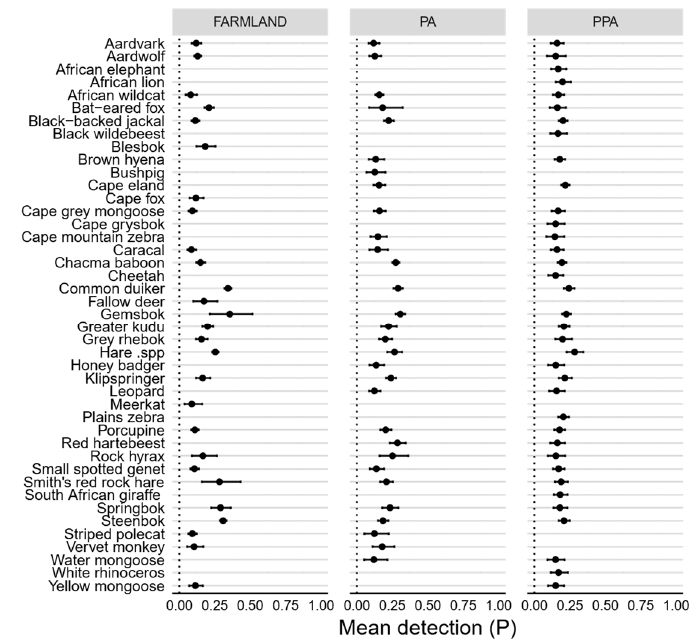
Figure A2. Caterpillar plots showing posterior means of detection (P) probabilities per species, as estimated under a hierarchical multi-species occupancy model, in farmland, PA and PPA. Error bars represent 95% Bayesian credible